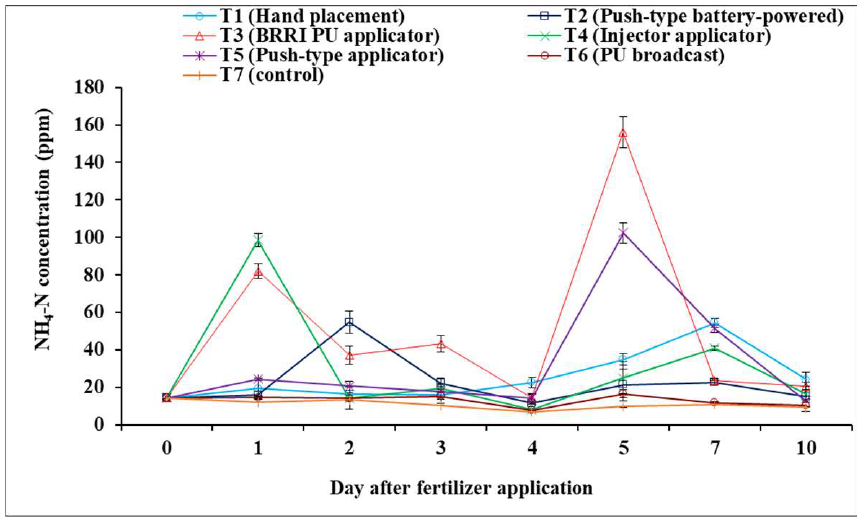
Figure 2. Trend of soil NH 4+ -N release under different methods of urea fertilizer application in T. Aman rice field at BAU Farm.